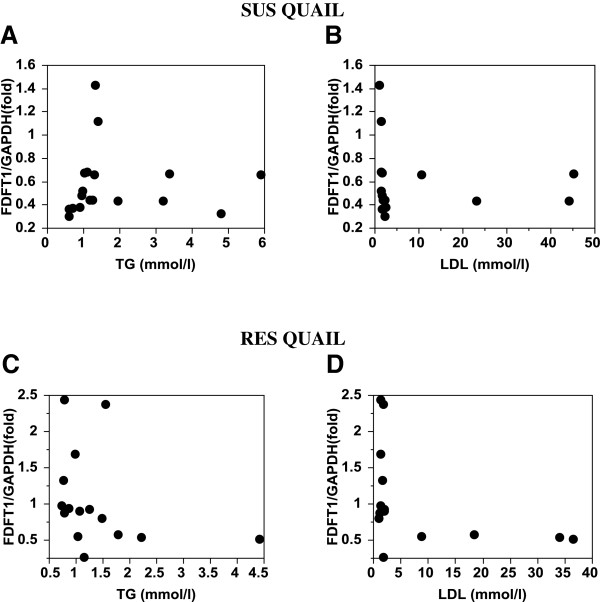
FDFT1expression in SUS and RES liver relative to plasma triglyceride and LDL levels.